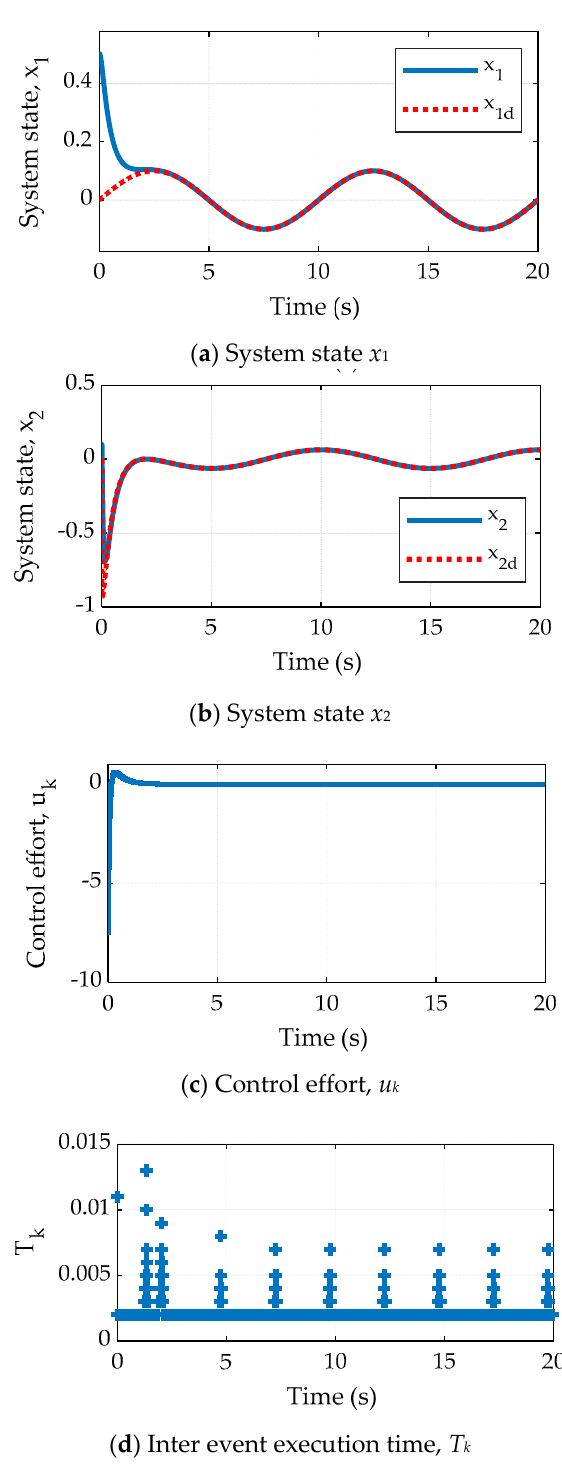
Figure 9. Closed-loop response for trajectory tracking control using optimized event-triggered con- trol.